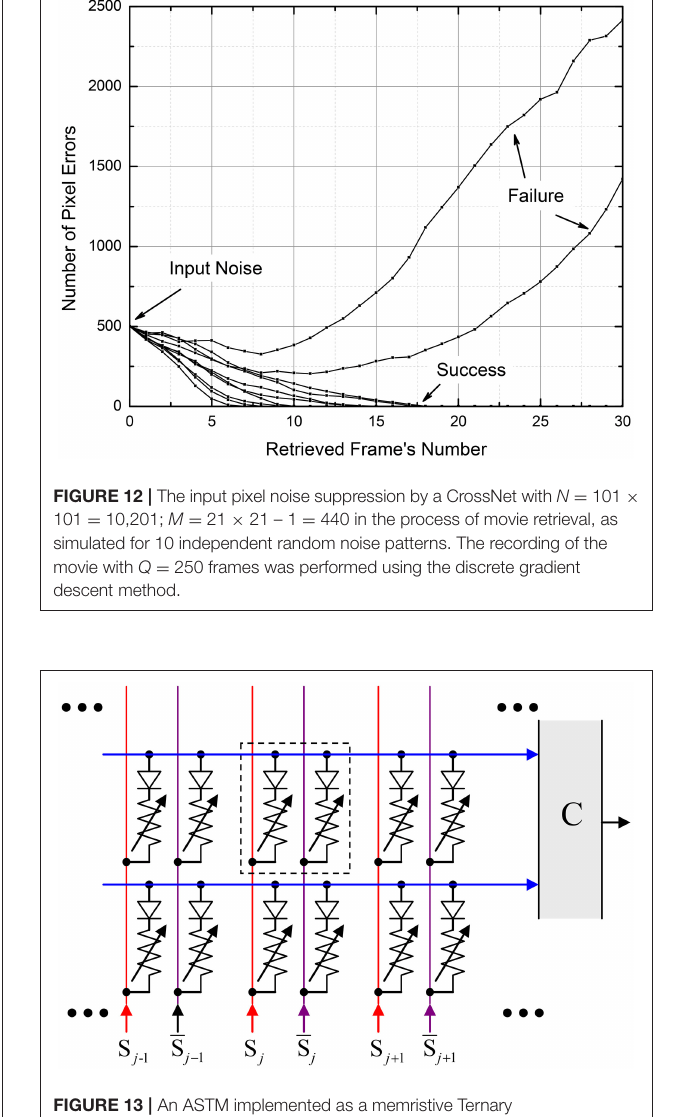
is induced by feeding each pair of column lines with voltages { V 0 , 0}, in the order dictated by the value of the corresponding binary pixel of the input frame. If the bit recorded in a cell corresponds to the input bit (i.e., if the input voltage V 0 > 0 corresponds to the ON state of the corresponding crosspoint device, with a high conductance, while the input voltage 0, to the OFF state, with its very low conductance), the feed does not result in a noticeable current through the cell. As a result, if a recorded frame exactly matches the input one, the row line’s voltage stays high. On the contrary, if some bits of a recorded frame are different from those of the input frame, the corresponding row line discharges, with the rate proportional to the number of misfit bits, i.e., to the Hamming distance between these two-bit strings. The discharge rates of all rows are